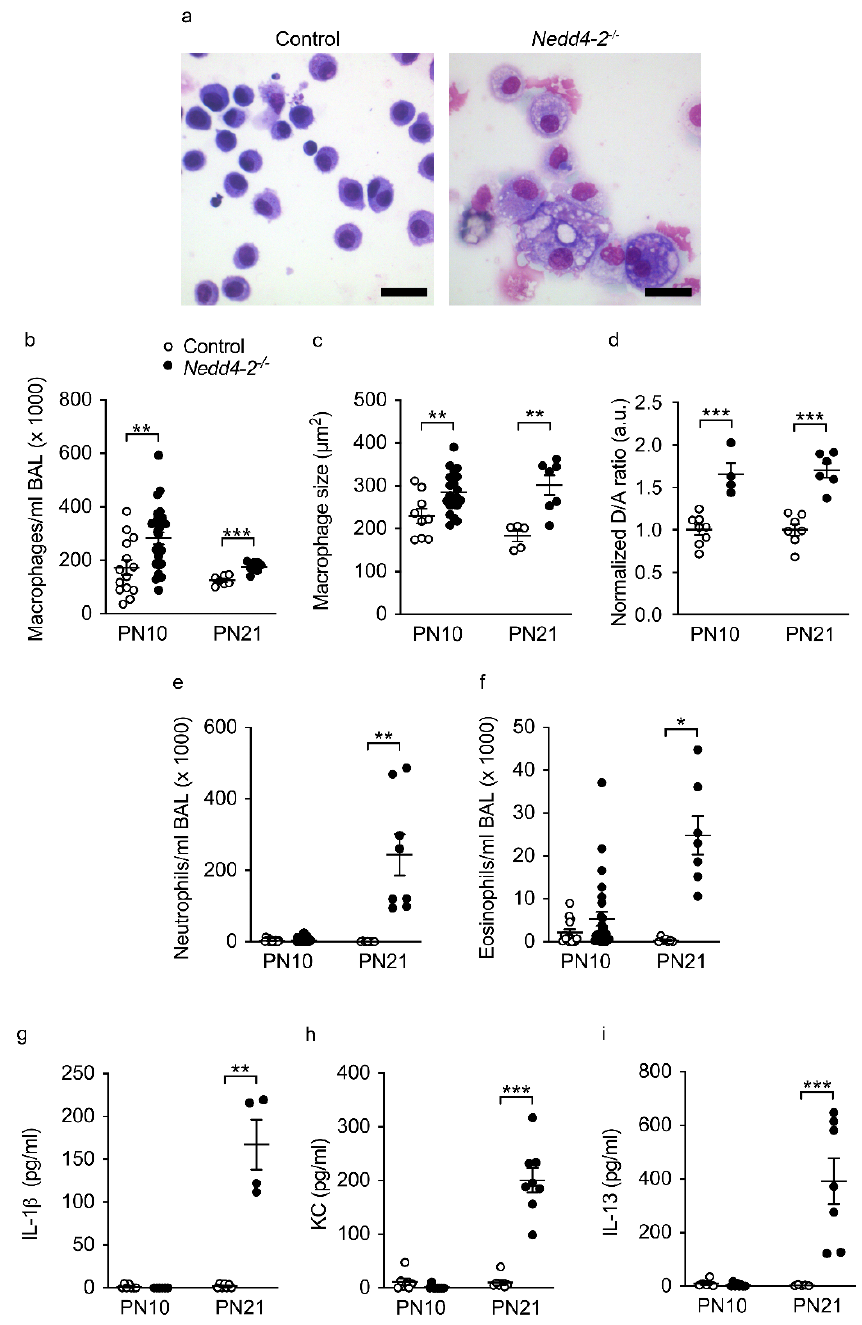
Figure 3. Development of pneumonitis in neonatal mice with congenital deletion of Nedd4-2 : ( a ) Representative micrographs of BAL macrophages in 3-week-old congenital Nedd4-2 −/− and control mice. Scale bars, 20 µm. ( b , c ) Number ( b ) and size ( c ) of macrophages in BAL. ( d ) Quantification of Mmp12 activity on the surface of BAL macrophages using the membrane-bound FRET reporter Laree1. Mmp12 activity was determined from the donor to acceptor (D/A) ratio of fluorescence emission produced by Mmp12-mediated cleavage of Laree1. Data were normalized to age-matched control mice. ( e , f ) Number of neutrophils ( e ) and eosinophils ( f ) in BAL of 10-day and 3-week-old congenital Nedd4-2 − / − and control mice. ( g – i ) Concentrations of IL-1 β ( g ), KC ( h ) and IL-13 ( i ) in BAL supernatant of 10-day and 3-week-old congenital Nedd4-2 − / − and control mice. n = 4–27 animals per group. * p < 0.05, ** p < 0.01, *** p < 0.001. Data are shown as mean ± S.E.M.